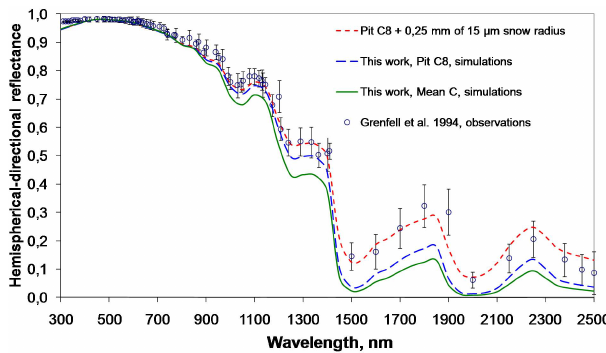
Fig. 19. Comparison between the reflectance of Grenfell et al. (1994) and that calculated from our snow data using DISORT and illumination and viewing conditions similar to those of Grenfell et al. (1994). Calculations using the stratigraphy of pit C8, to which a snow layer 0.25mm thick with crystals 15µm in radius match the observations of Grenfell et al. (1994) fairly well.